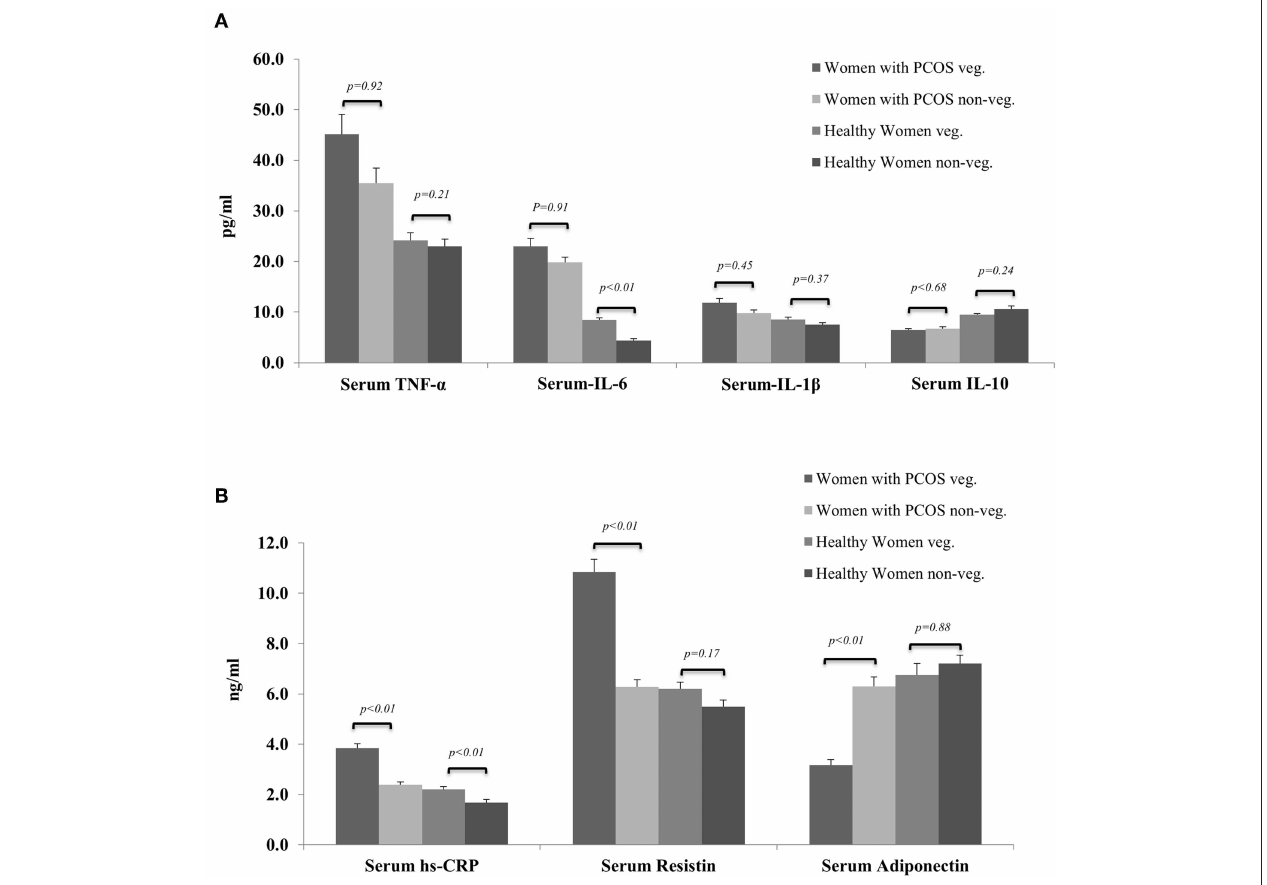
FIGURE 2 | Showing comparison of serum levels of biomarkers of inflammation among women with PCOS and healthy controls from vegetarian and non-vegetarian backgrounds. (A) Serum TNF- α , IL-6, IL-1b, and IL-10. (B) Serum hs-CRP, resistin, and